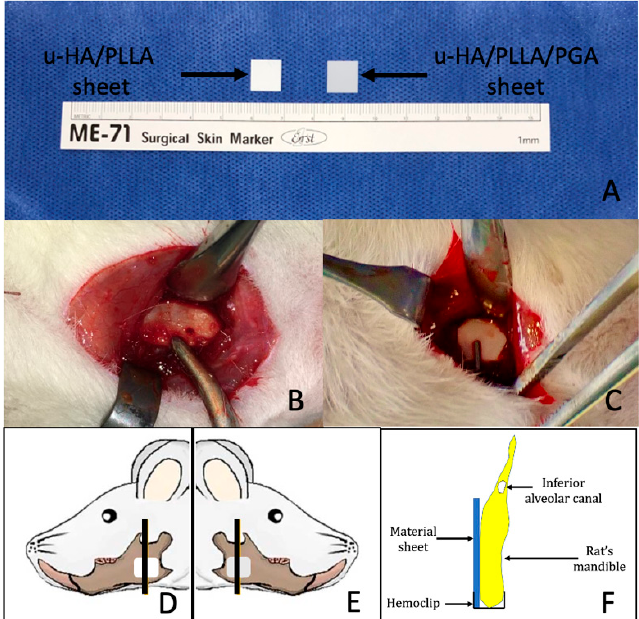
Figure 1. Surgical procedure. ( A ) u-HA/PLLA sheet (left) and u-HA/PLLA/PGA sheet (right) with the same dimensions: 5 mm length × 5 mm width × 0.3 mm thickness. ( B ) The mandibular angle area was exposed on the right side. ( C ) Fixation of the reconstruction material using a hemoclip. The black vertical lines in ( D ) and ( E ) indicate the sites at which samples were collected for analysis. u-HA/PLLA material was applied on the left side and u-HA/PLLA/PGA material on the right side. ( F ) Schematic coronal view of one specimen.